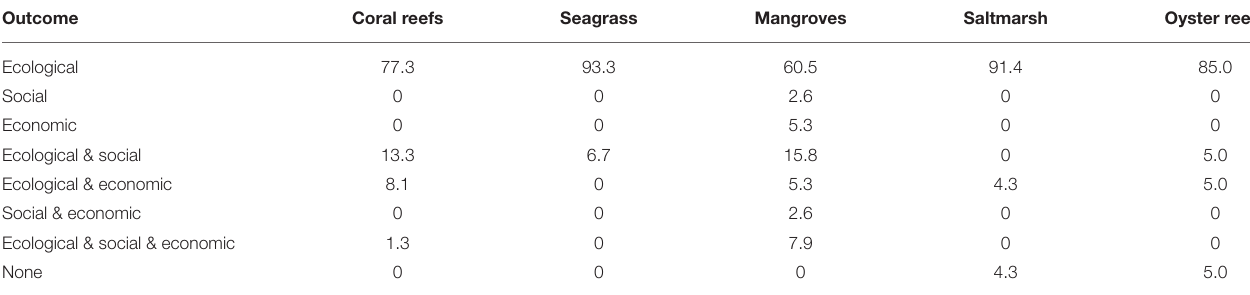
TABLE 2 | Percentage of outcome categories reported.